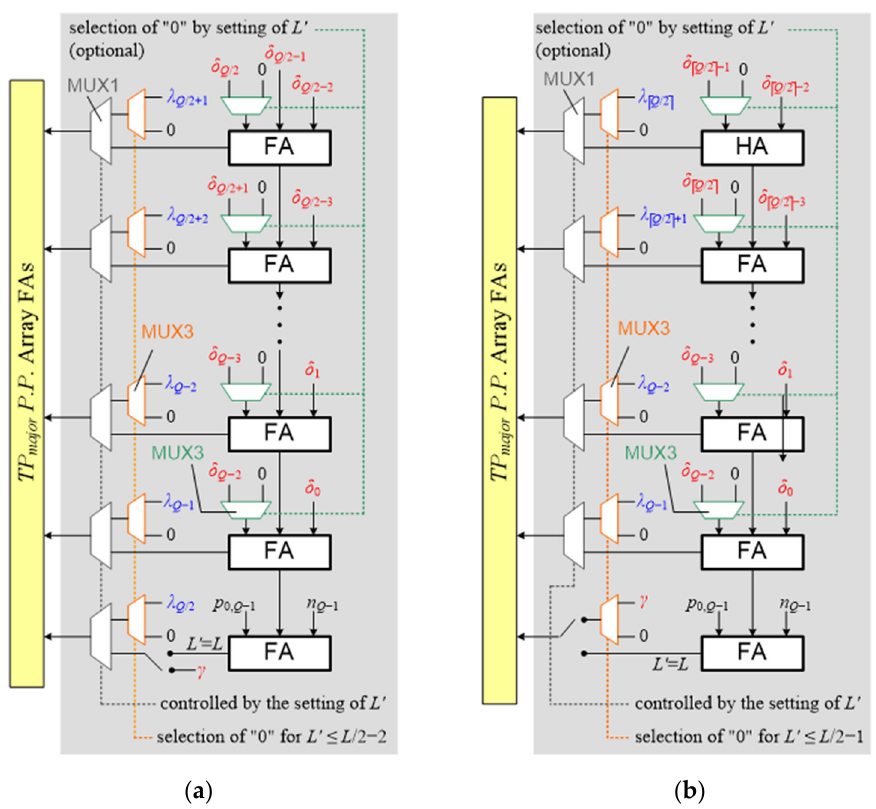
Figure 8. Hardware configuration for BWATEC biasing of a general L -bit FWBM: ( a ) L = 2 n , and n is even; ( b ) L = 2 n , and n is odd. Table 4. HW resources usage of a general L -bit FWBM for various L ′ -bit inputs using the BWATEC scheme ( Q = L /2). MP / TP major HW Resources